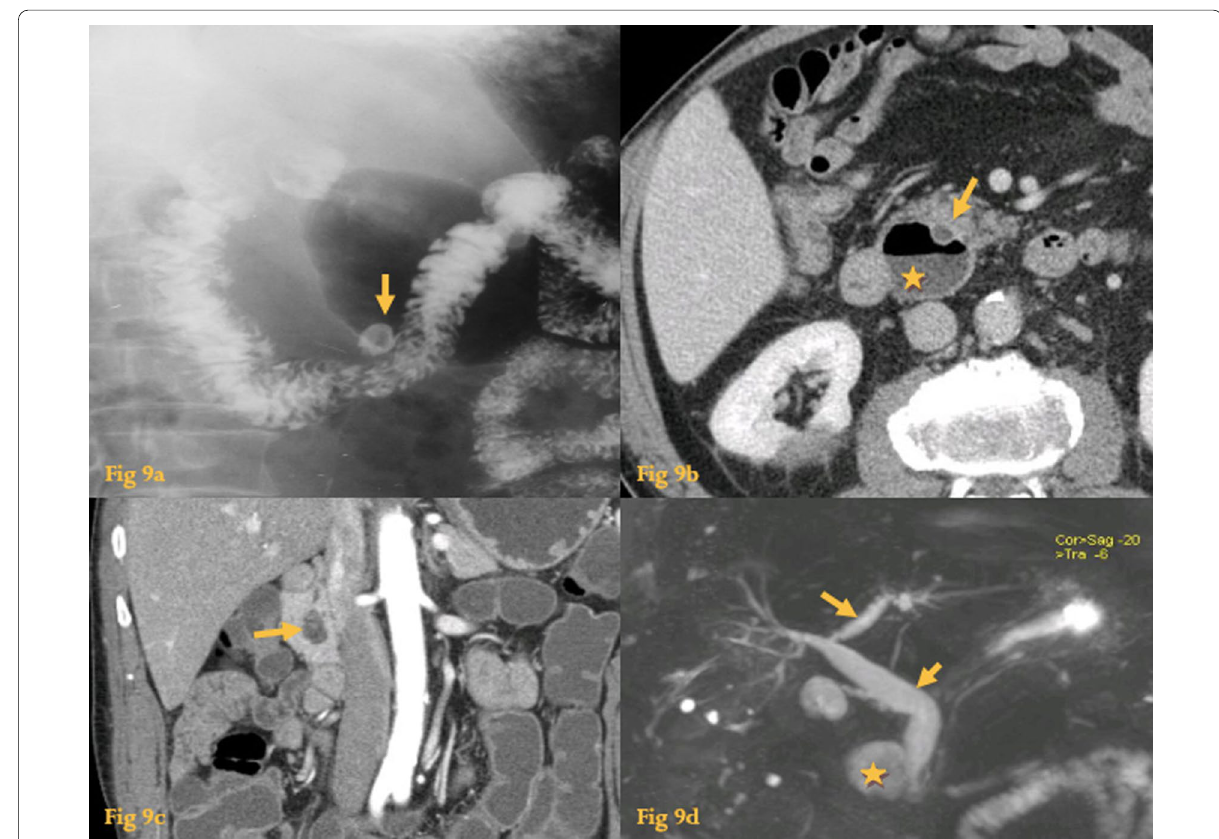
Fig. 9 Diverticula. Upper gastrointestinal series with barium contrast ( a ) shows an outpouching of the upper wall of the third part of the duodenum (arrow). Abdominal CT ( b ) shows an air and fluid‑filled diverticulum on the inner aspect of the descending duodenum (asterisk), adjacent to the CBD (arrow). In another patient ( c ), an heterogeneous fluid and air‑filled diverticulum on the inner aspect of the descending duodenum (arrow) mimicked an abscess. MRCP ( d ) in a patient that had bile duct dilatation (arrows) with associated cholangitis due to a periampullary diverticulum